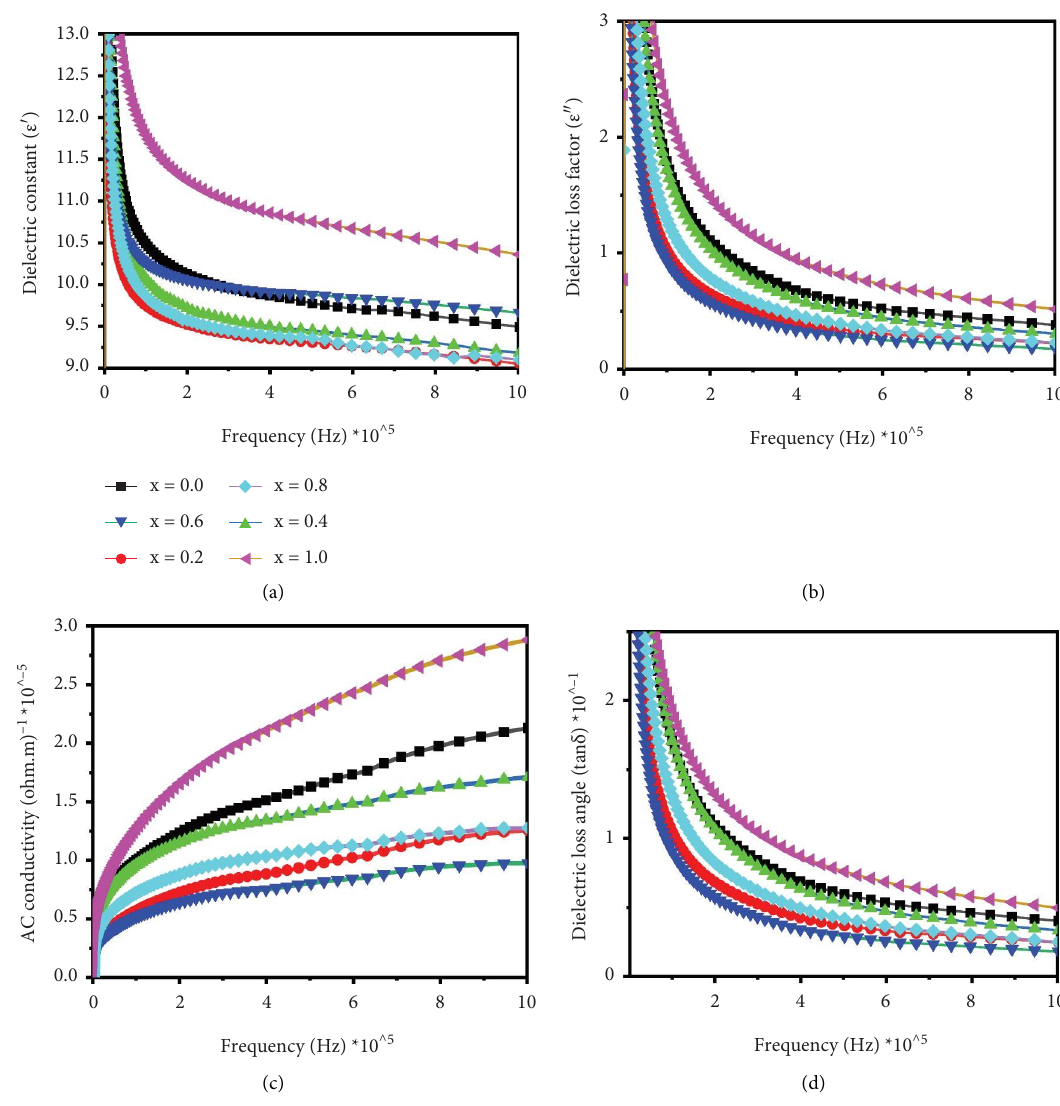
Figure 13: Dielectric parameters of all the prepared Co